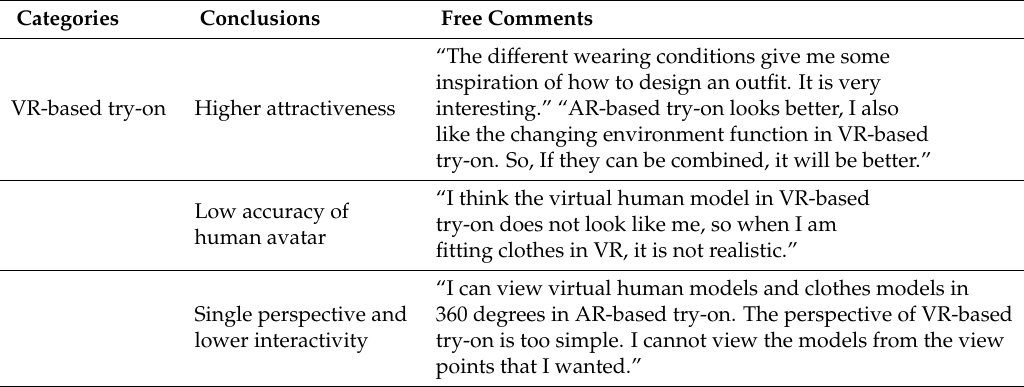
Table 4. Illustrative excerpts and main conclusions of free comment mentioning the VR-based